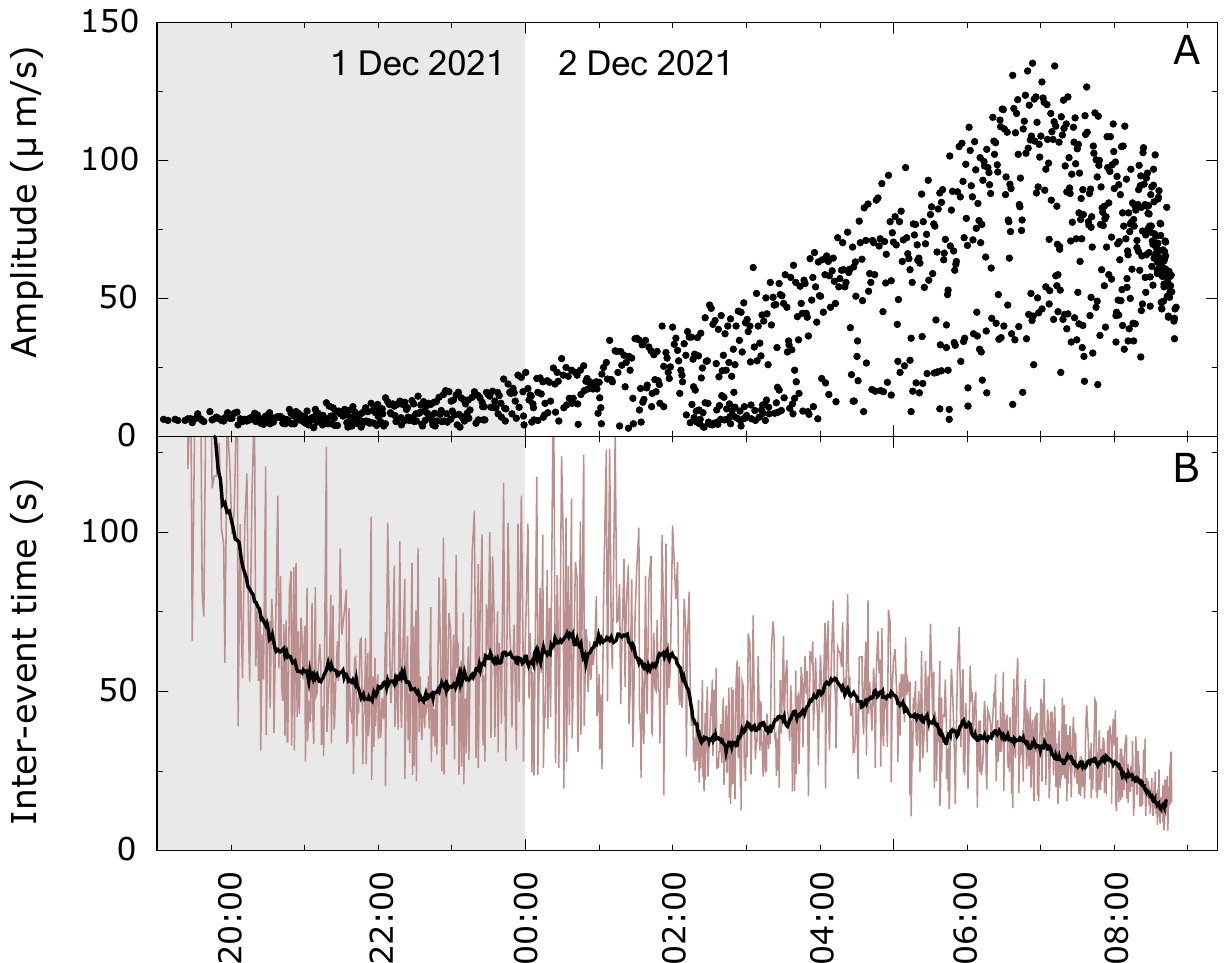
Figure 11: Seismic characteristics of the drumbeat sequence, [A] Peak to peak amplitude of the events detected by matched filtering. [B] Inter-event time for events recorded during the sequence before merging into tremor. Individual measurements are shown in the background (brown) with the black curve in foreground presenting an averaging over 30-point moving